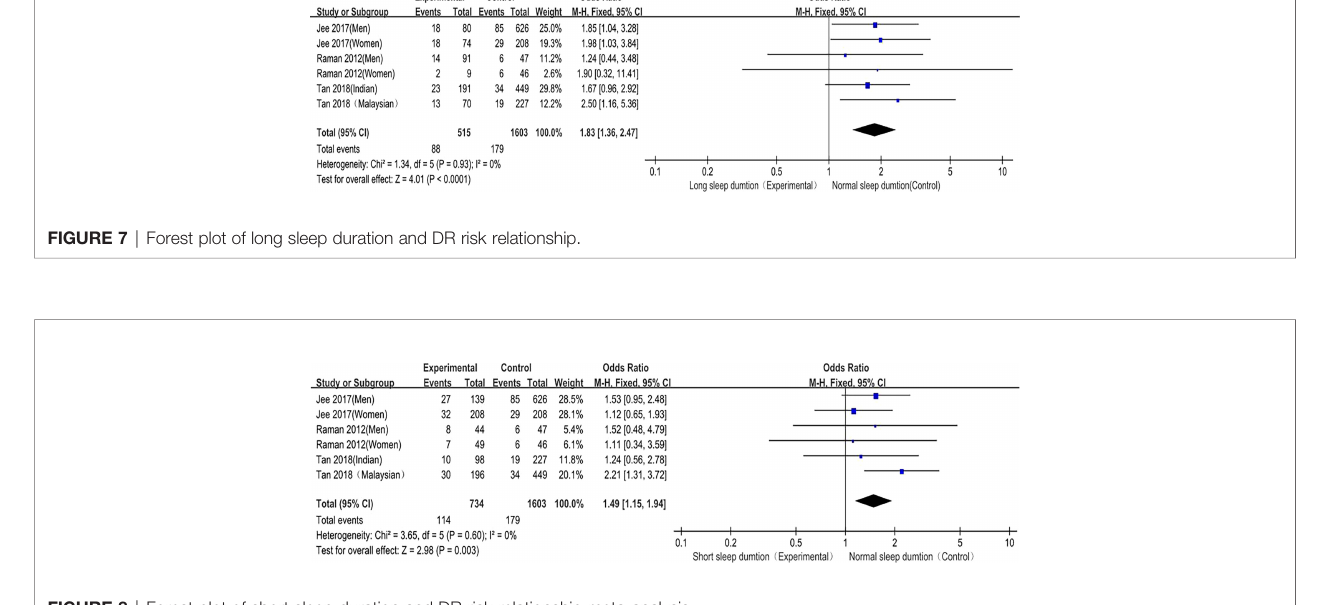
FIGURE 8 | Forest plot of short sleep duration and DR risk relationship meta-analysis.